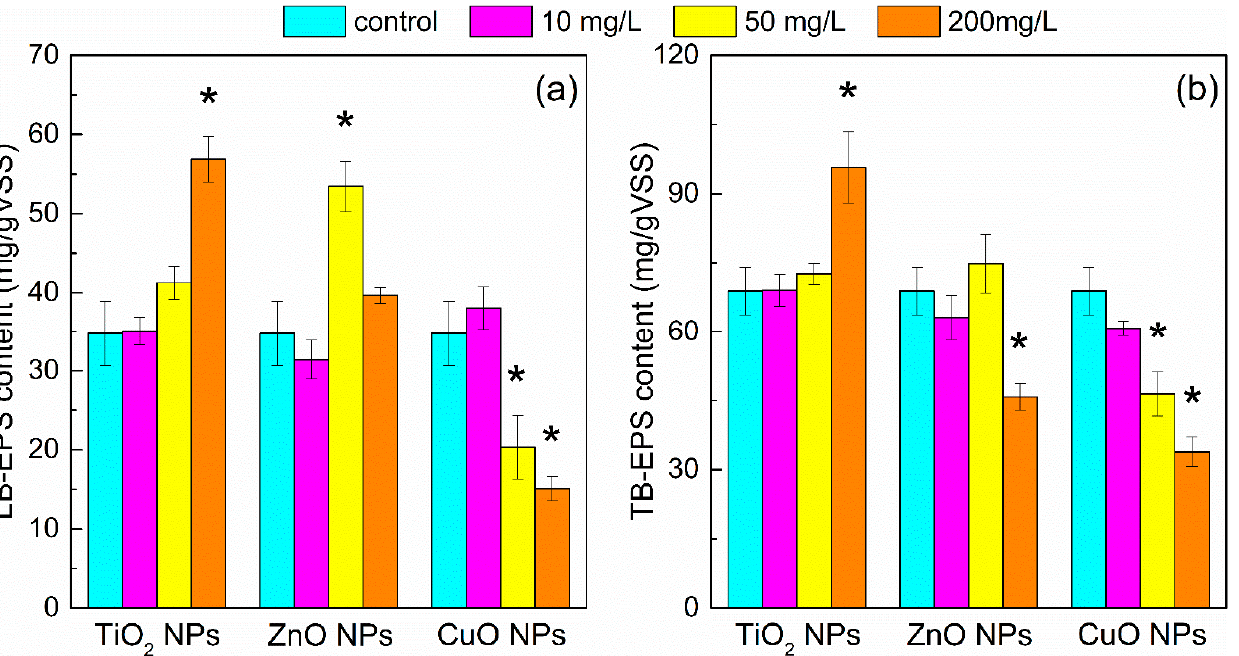
Figure 2. Effects of NPs’ exposure on the production of LB-EPS ( a ) and TB-EPS ( b ). Asterisks indicate statistical differences ( p < 0.05) from the control. * Error bars represent standard deviations determined from triplicate measurements.